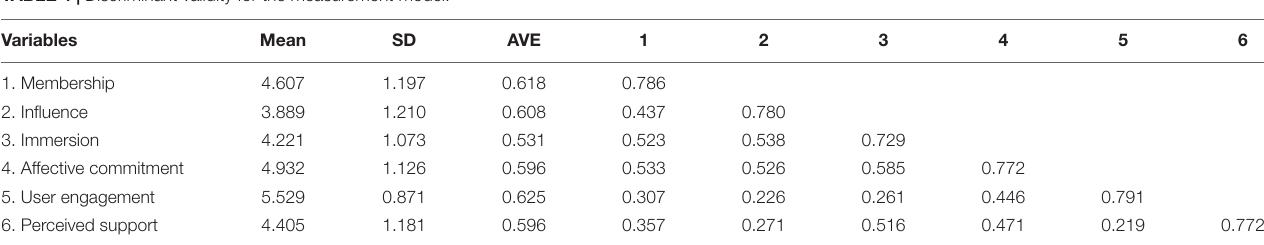
TABLE 4 | Discriminant validity for the measurement